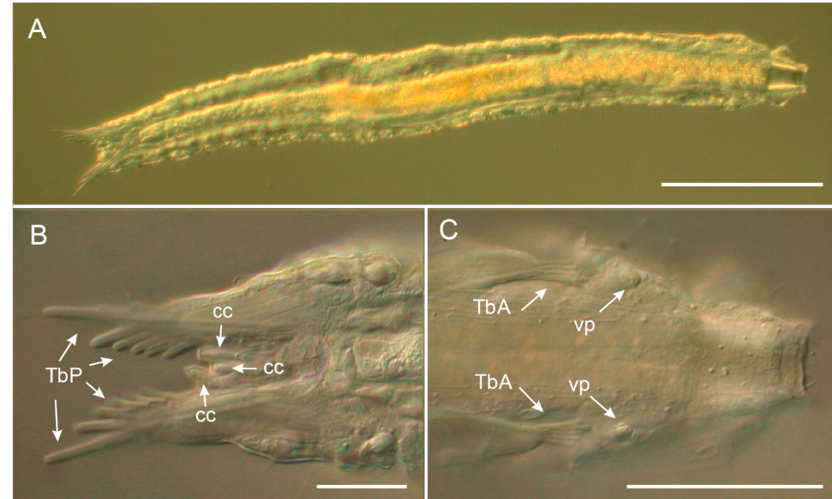
Figure 4. Adult specimen of Paraturbanella tricaudata sp. nov. (2002–2003 sampling). ( A ) Habitus; ( B ) ventral view of the posterior body end, showing posterior adhesive tubes (TbP) and tree caudal cones (cc); ( C ) ventral view of the anterior region, showing the anterior adhesive tubes (TbA) and ventral papillae (vp). Scale bars: A = 100; B , C = 50 µm.